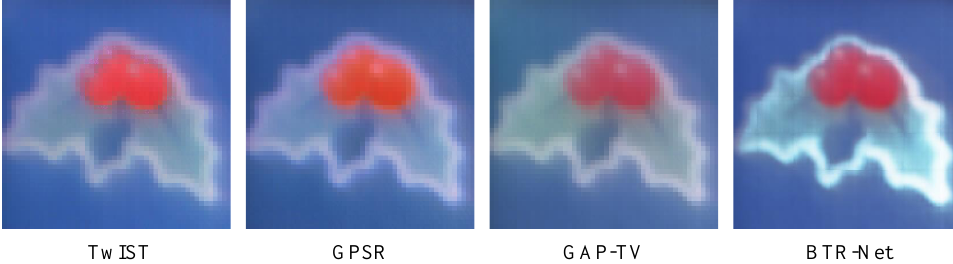
Figure 10. Visual quality comparison of the reconstructed results. Figure 11 draws the reflection spectra of two representative points whose positions are marked on the RGB image, where the x -axis and y -axis represent wavelength